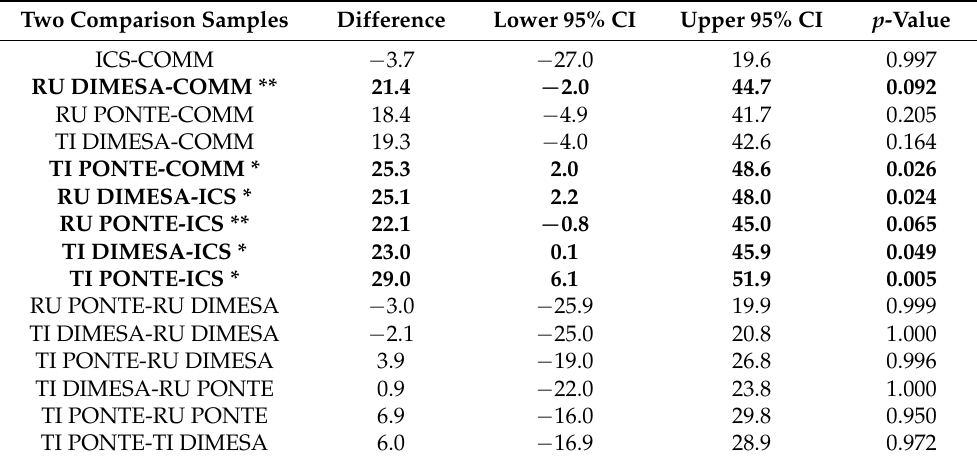
Table 5. Pairwise comparison of glycemic index among all pasta samples.